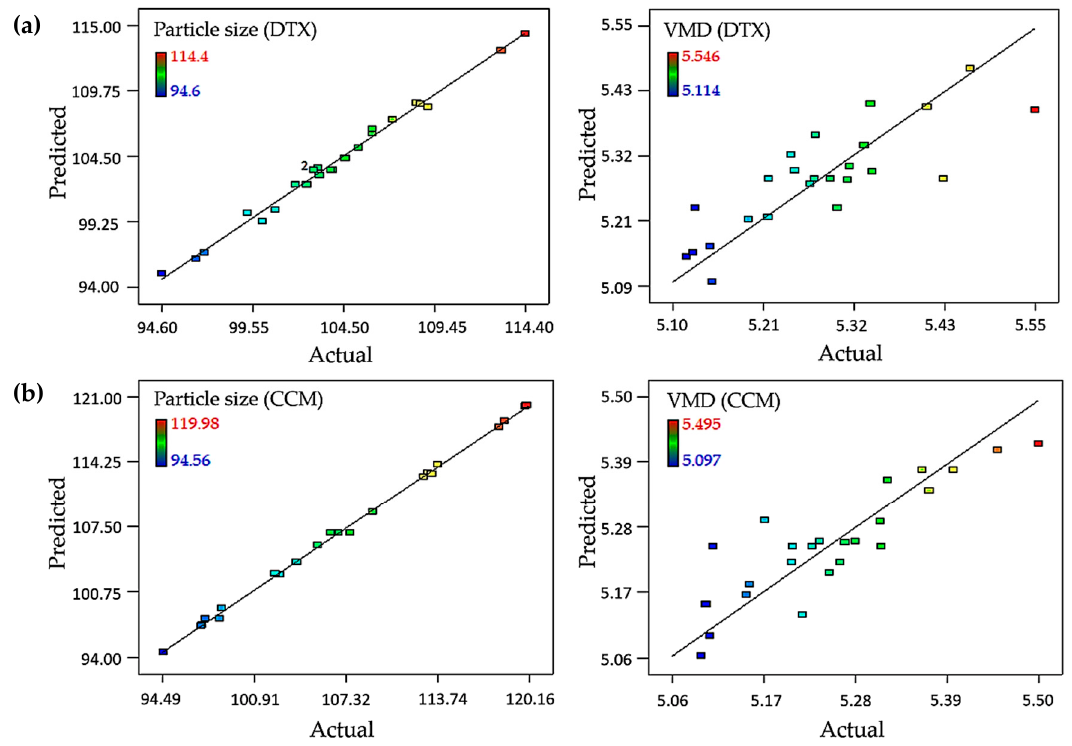
Figure 1. Scatter plot of predicted versus actual for ( a ) DTX-loaded nanoemulsion and ( b ) CCM-loaded nanoemulsion towards particle size and aerosol size (VMD).